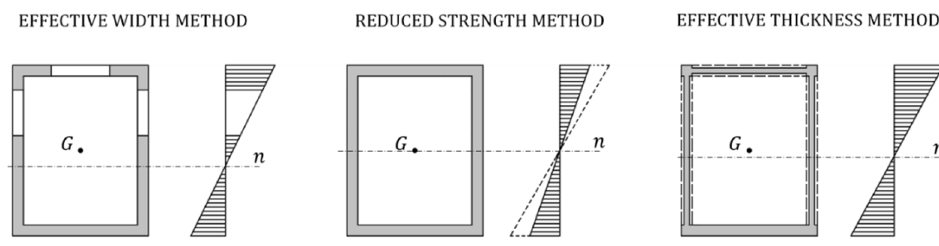
Figure 2. Comparison of the different design approaches for a rectangular section in bending.